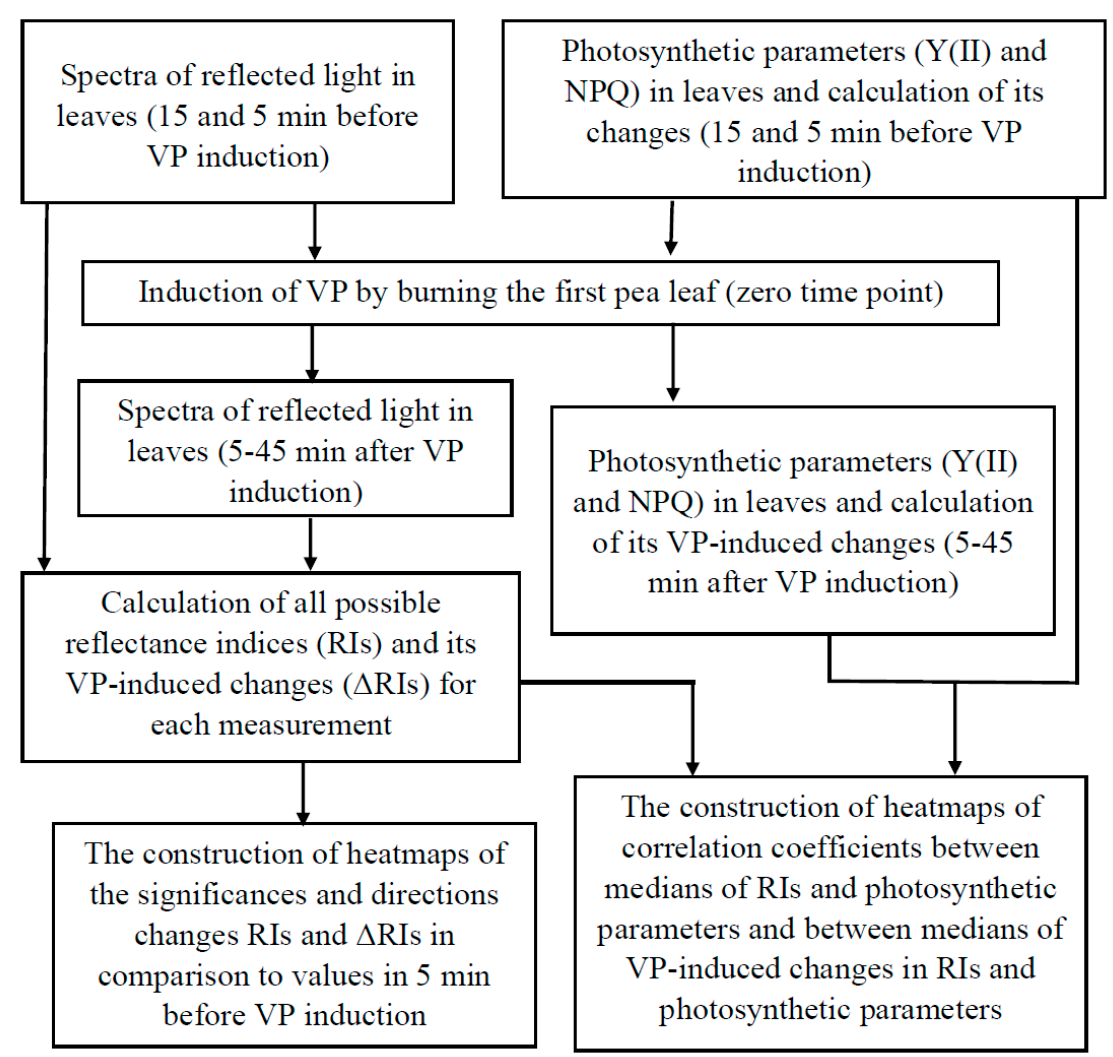
Figure 1. General scheme of analysis of spectra of the reflected light and photosynthetic parameters (the quantum yield of photosystem II, Y(II), and non-photochemical quenching of chlorophyll fluorescence, NPQ) measured in the second pea leaf before and after induction of variation potential (VP) by local burning of the first leaf.